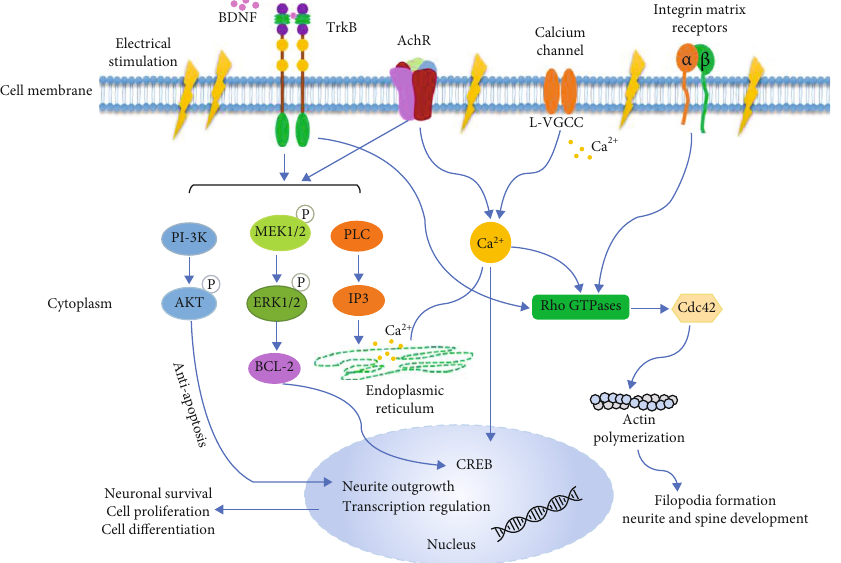
Figure 3: Potential mechanism of electrical stimulation on neural di ff